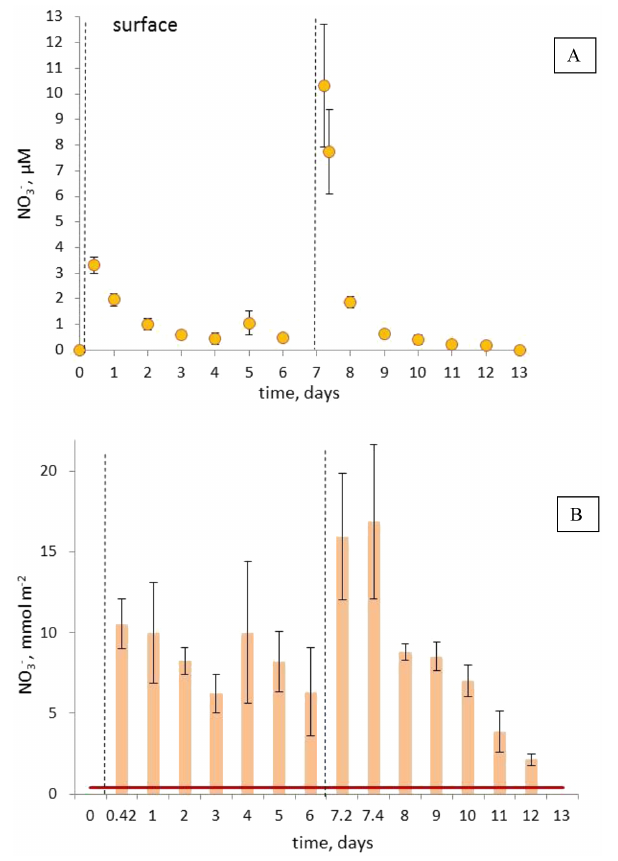
Figure 1. (A) Mean NO − concentration (µmolL − 1 ) during the 3 DUNE-2-R experiment in the Dust-meso at the surface (0.1m in depth). The dotted lines represent the time of the dust seedings. Data represent the average and standard deviations of the three replicate mesocosms. NO − concentrations were under the detection limit 3 (<30nM) in the Control-meso and outside over the duration of the experiment, as well as in the Dust-meso before seeding (day 0) and at the end of the experiment (day 13). (B) Integrated NO − (mmol 3 Nm − 2 ) over the depth of the mesocosm (12.5m) in the Dust-meso during the DUNE-2-R experiment. Assuming a maximum NO − 3 concentration of 30nM in the Control-meso, the integrated NO − 3 should be lower than 0.4mmolNm − 2 (red